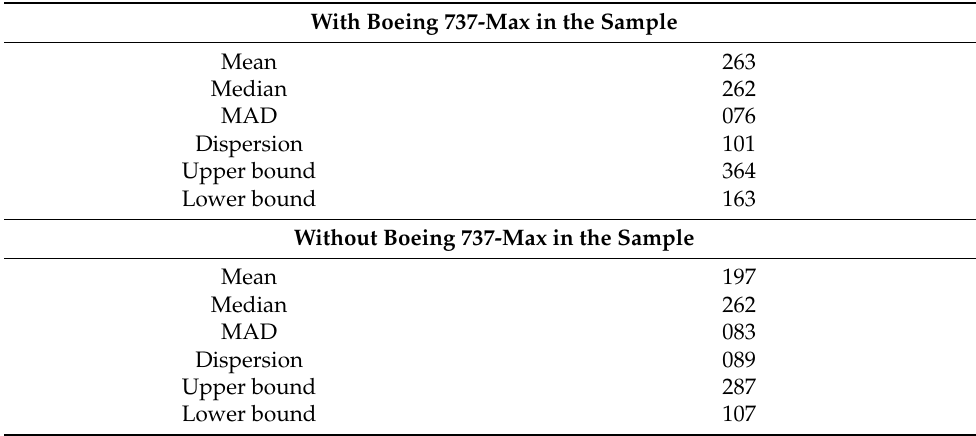
Table 5. Mean and dispersion of the 5000 Monte Carlo